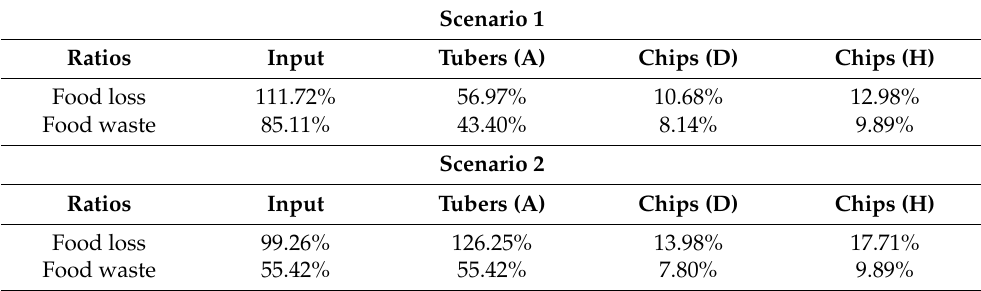
Table 3. Food loss and waste cost